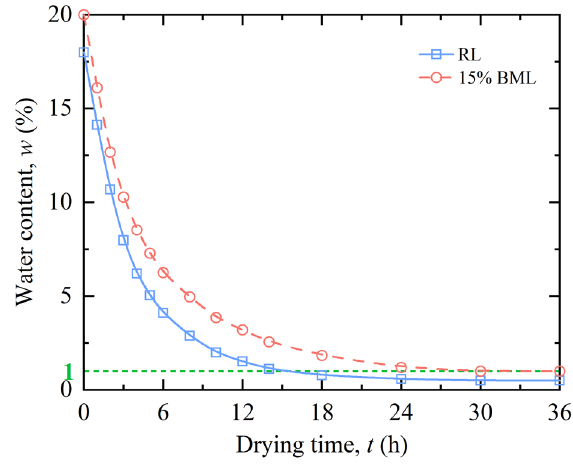
Figure 3. Relationship between water content and drying time.